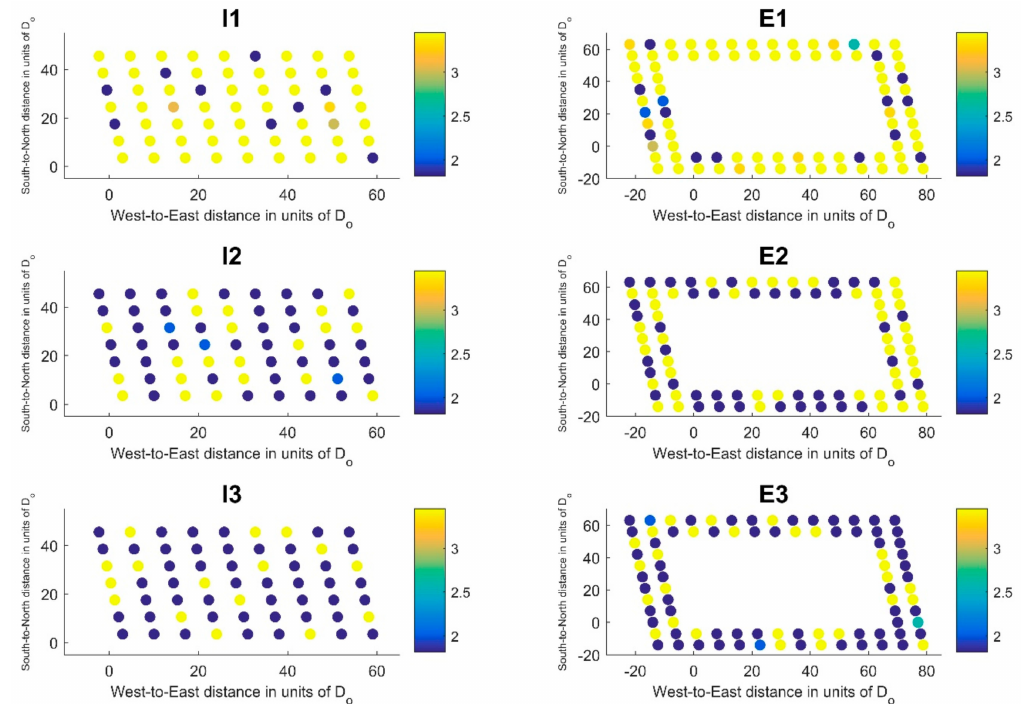
Figure 12. Rated power distribution in MW for the selected turbines for multiple turbines grid layouts.